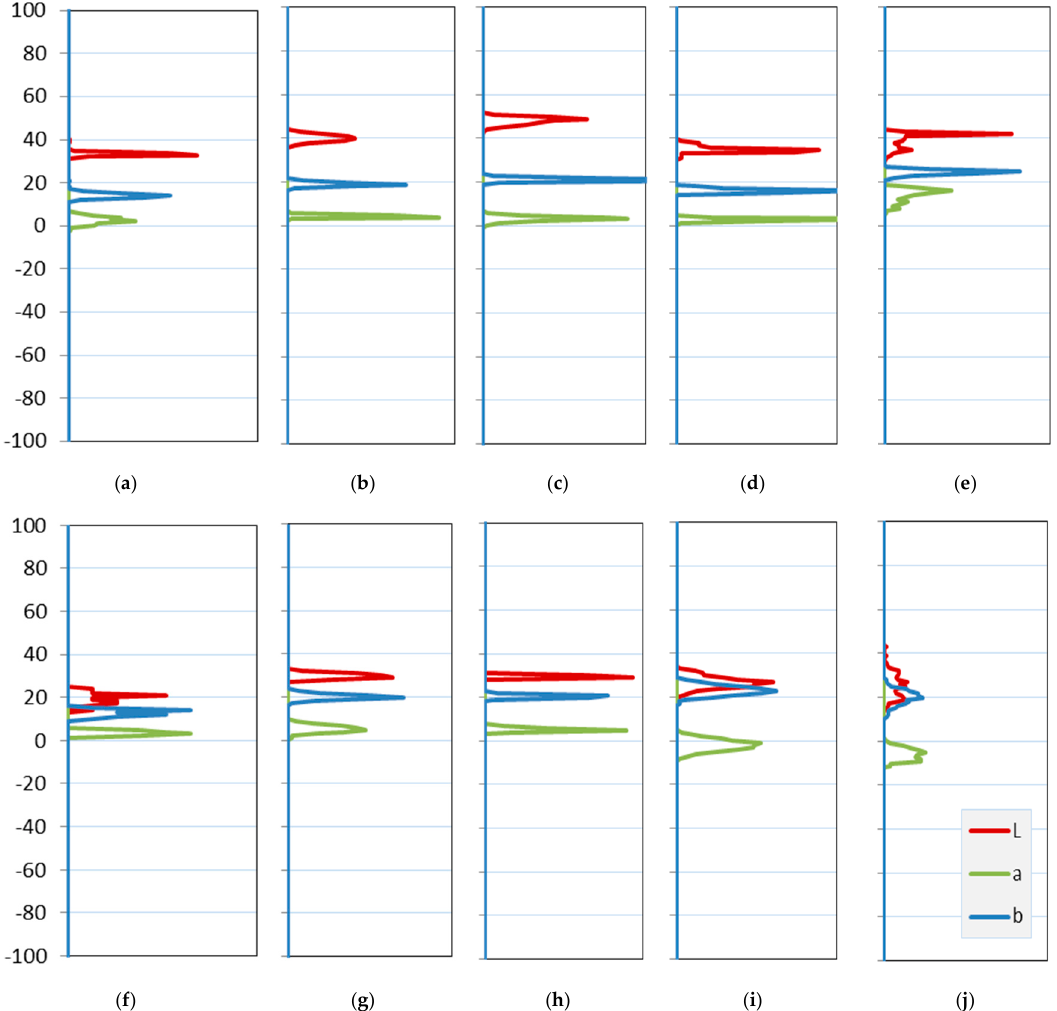
Figure A1. Signal distribution of backgrounds for Channels L, a and b. ( a ) Asphalt; ( b ) Fine chippings; ( c ) Red paving stones; ( d ) Stone steps; ( e ) Gray paving stones; ( f ) Gravel; ( g ) Sandy path; ( h ) Arable land; ( i ) Grazing land; ( j ) Grassland with dew.